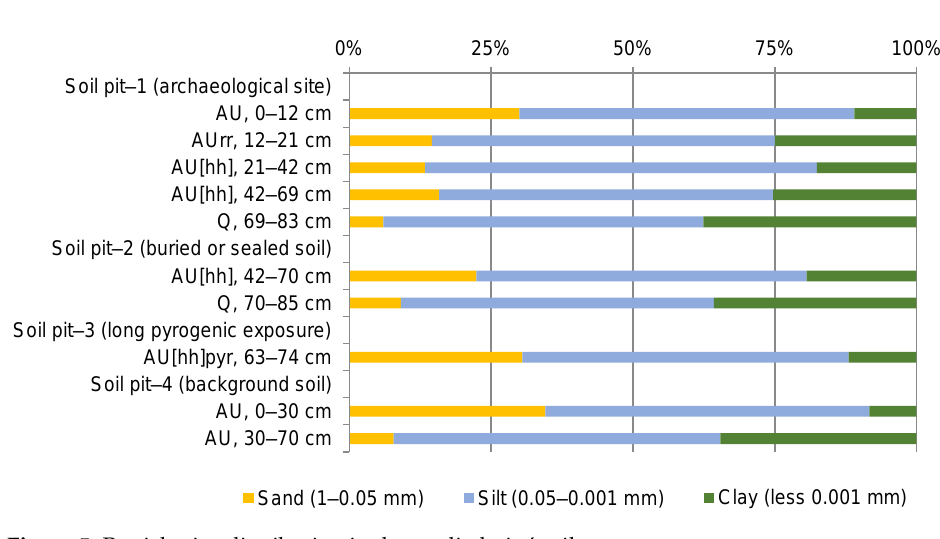
Figure 5. Particle size distribution in the studied pits ’ soils .